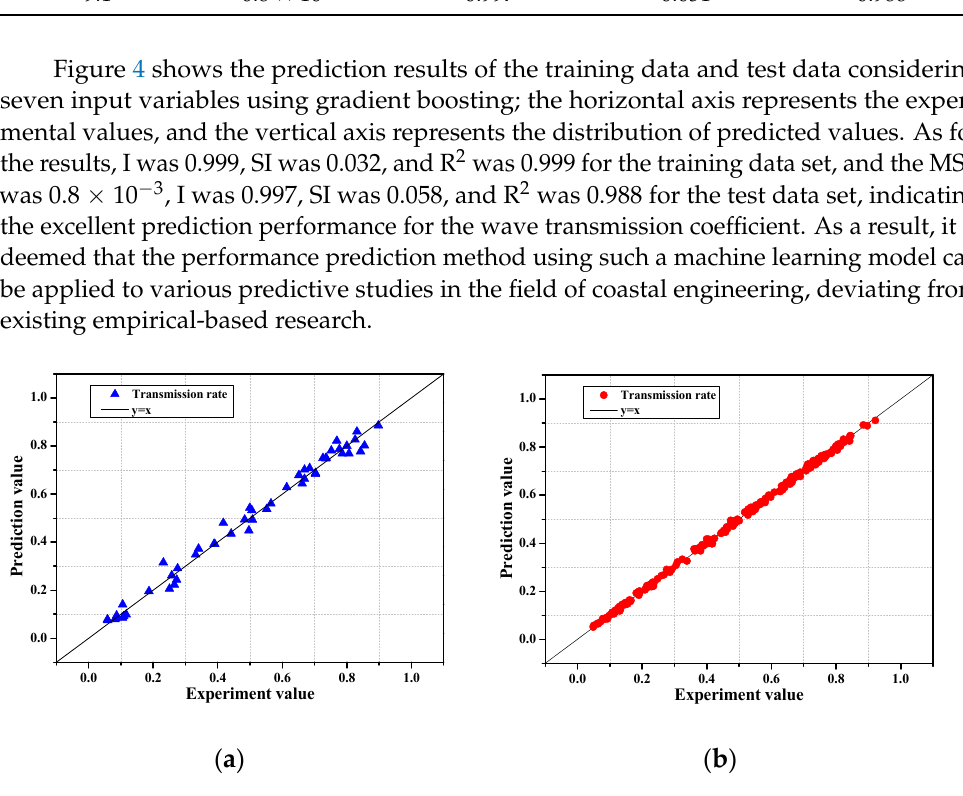
Figure 4. Distribution of experimental and predicted values according to the GBR model application. ( a ): Test set. ( b ): Training set.